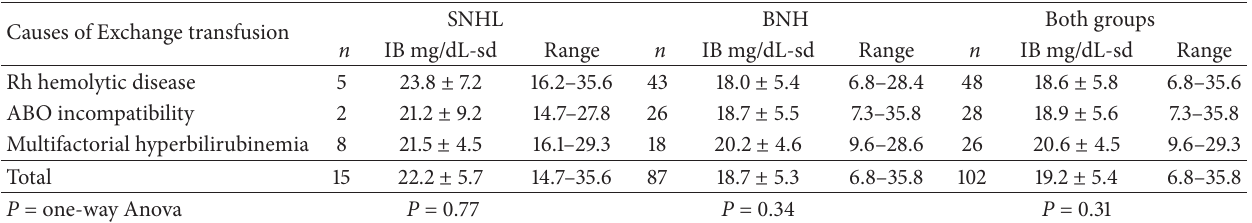
Table 1: Comparison of Indirect bilirubin levels in children with exchange transfusion for different causes ( 𝑛 = 102 ).